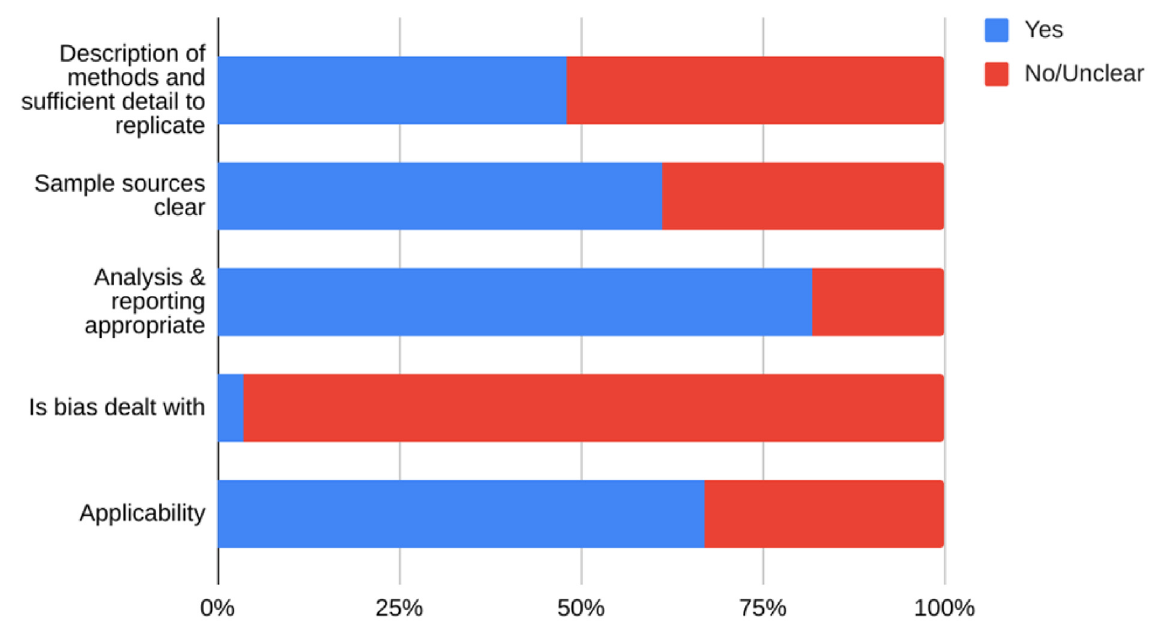
Figure 2. Risk of bias graph in primary studies of close contacts in SARS-CoV-2.